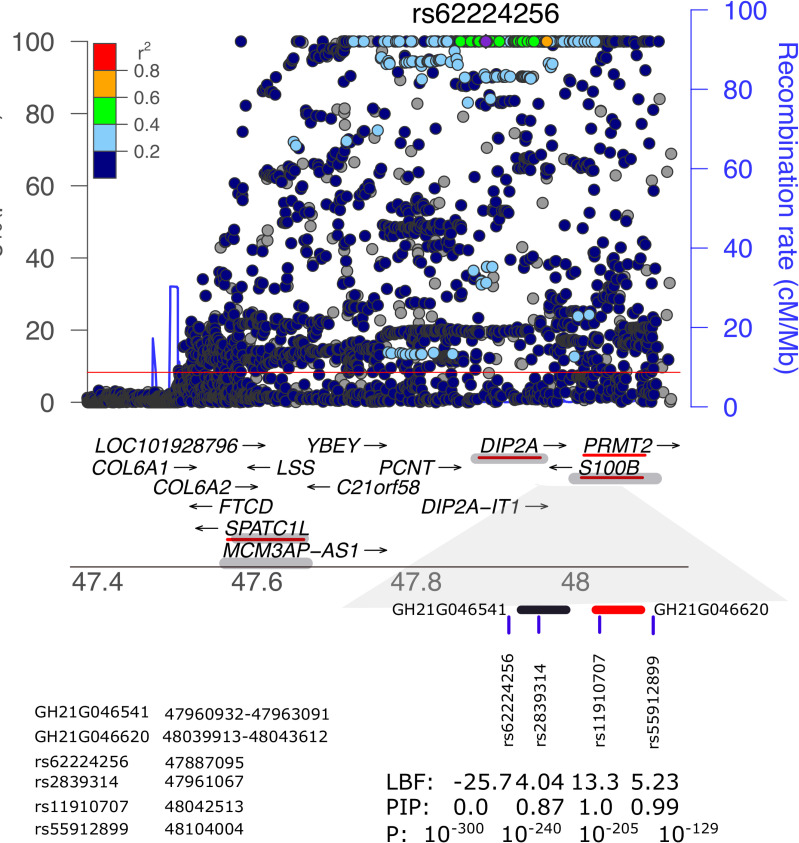
Annotation of the region indexed by rs62224256 associated with S100B.The top panel shows the regional plot. P values bellow 1x10-100 were censored at 1x10-100 for the clearness of illustration. Genes located in this region are shown in the middle panel. The sub-region contains rs662224256 is zoomed in approximately. Two enhancers are represented by the black and red bars. Genes regulated by the enhancers are underscored by red line and shaded bar when they are regulated by both enhancers. The log10 Bayesian Factor (LBF), posterior inclusion probability(PIP) of being included in the causal set and association p values (P) scales are shown in the same order as SNP rs-numbers. The genomic coordinates (build hg19) of SNPs and enhancers are shown on the lower-left panel.